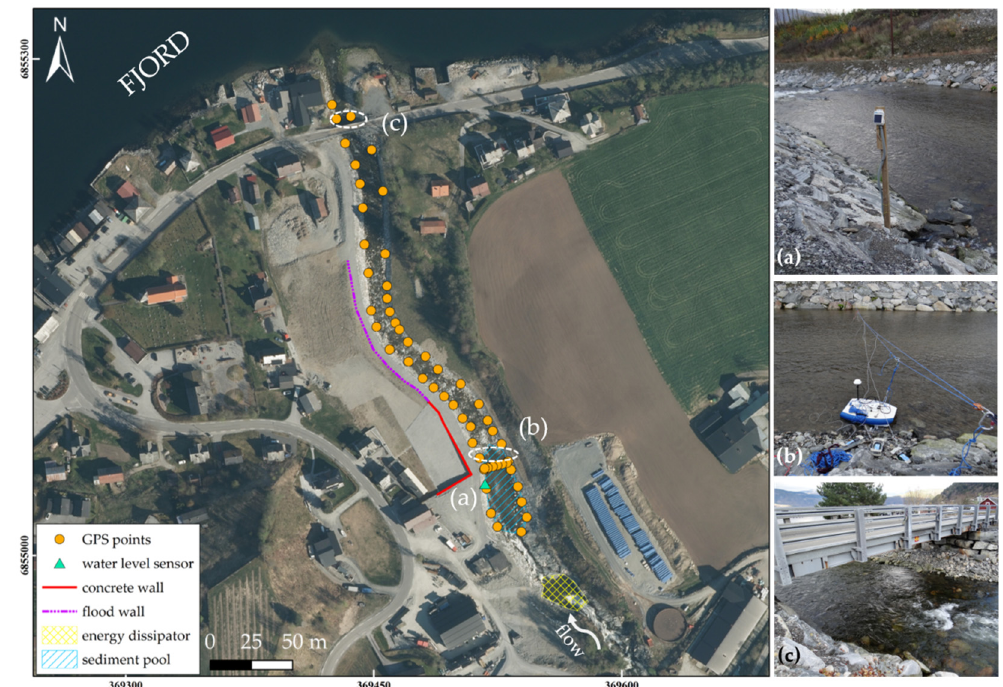
Figure 8. Flood protections and field survey in the restored the Storelva river in Utvik; ( a ) pressure transducer installed by the pool, ( b ) cross-section for discharge measurement with ADCP, ( c ) reconstructed bridge. Orthophoto in ETRS89, UTM33 [32]. Field photos taken by A. Moraru.